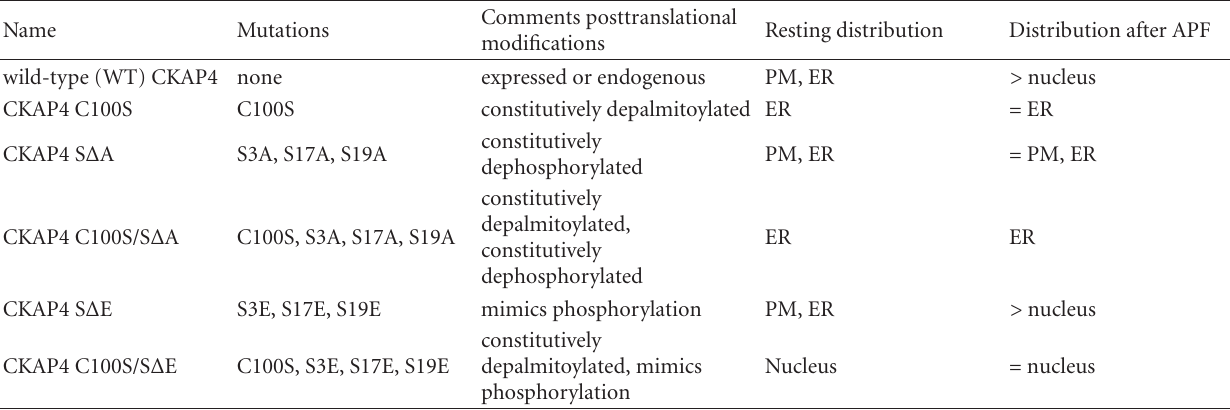
Table 1: Mutant constructs used to study CKAP4 phosphorylation and palmitoylation . CKAP4 mutants that mimic constitutive depalmitoyla- tion and various states of serine (S3, S17 and S19) phosphorylation were generated to determine their e ff ect on the subcellular distribution of CKAP4 in response to APF. CKAP4S Δ E translocated from the PM to the nucleus in response to APF; CKAP4S Δ A localized to the PM but did not translocate to the nucleus in response to APF; none of the C100S mutants were expressed on the PM; CKAP4C100S/S Δ E was expressed in the nucleus. The results indicate that CKAP4 must be palmitoylated for PM expression and depalmitoylated and phosphorylated for translocation to the nucleus. A summary of these results are provided in the table.